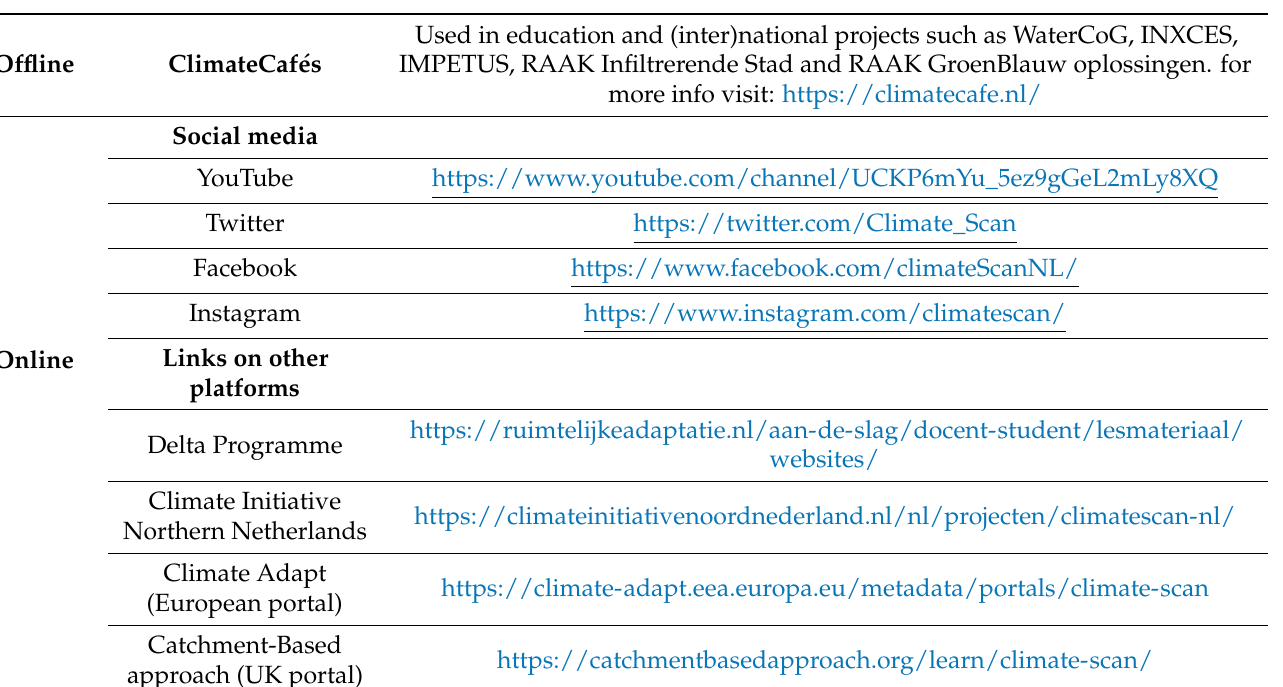
Table 1. Promotion and dissemination channels of